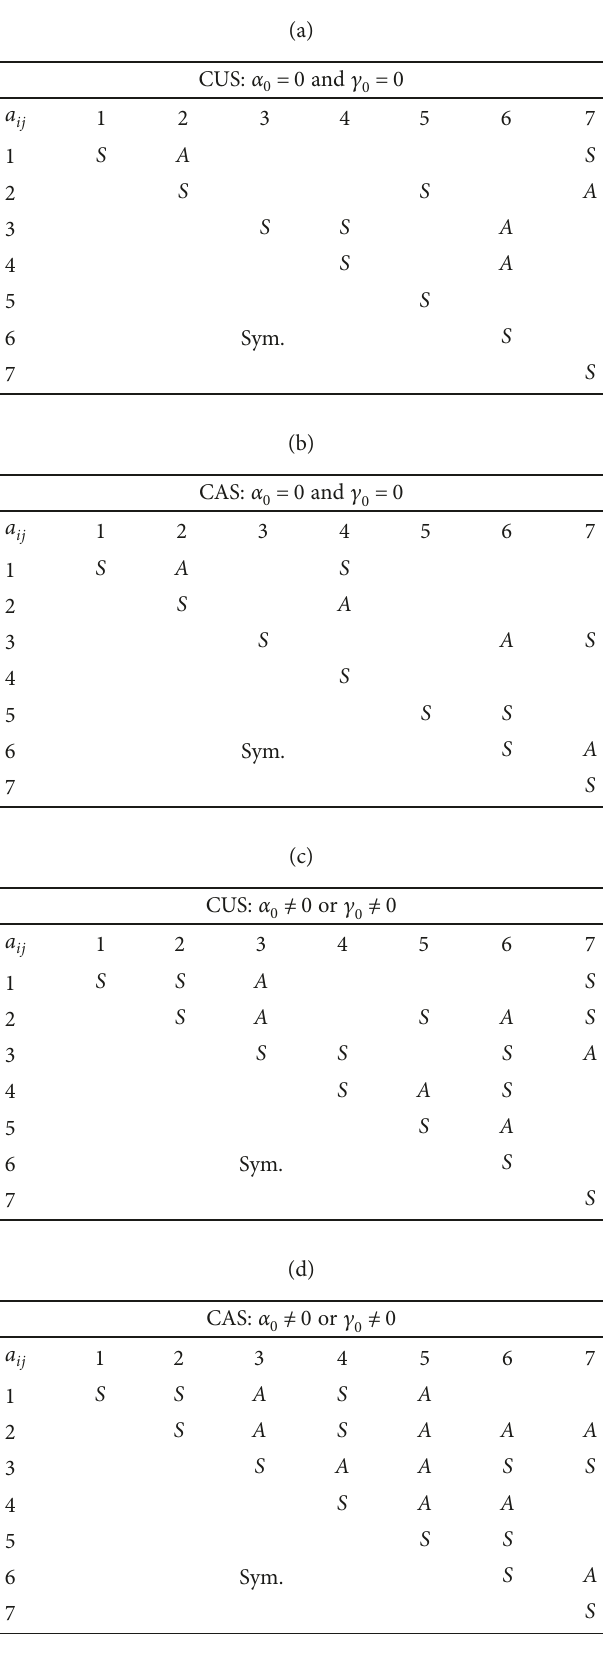
Table 3: Sti ff ness coe ffi cients of Model A and Model C.